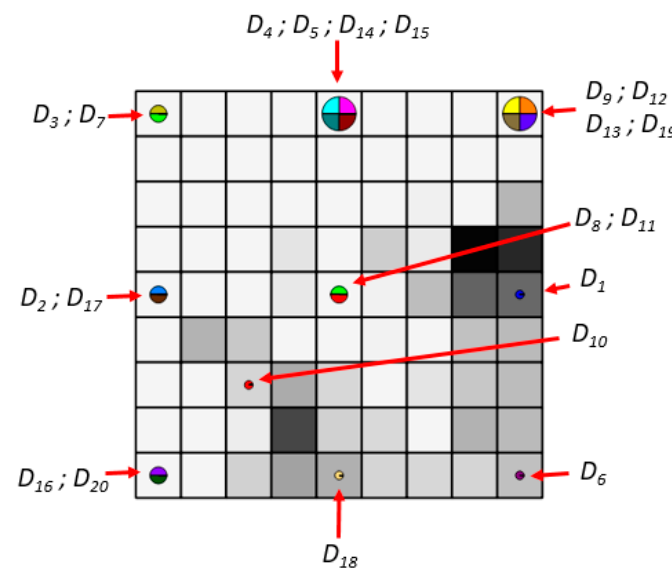
Figure 7. 9 × 9 self-organizing map: fifth question ( (cid:1843) (cid:2873) ).